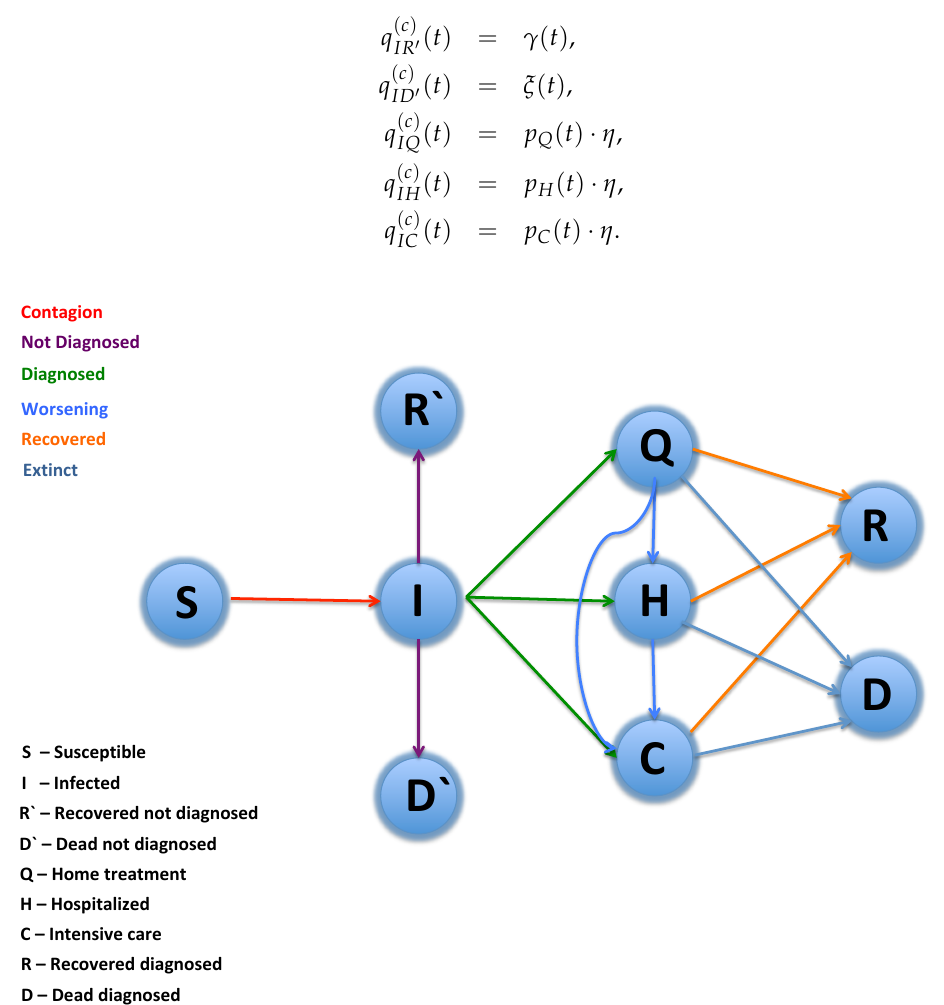
Figure 1. COVID-19 model. Rates γ ( t ) and ξ ( t ) and probabilities p Q ( t ) , p H ( t ) , and p C ( t ) have been considered time-dependent to model the improvements in the treatment that reduces the recovery time and chance of death as time passes. Rates γ ( t ) and ξ ( t ) are also used to describe the recovery and death from states different from I , i.e.,